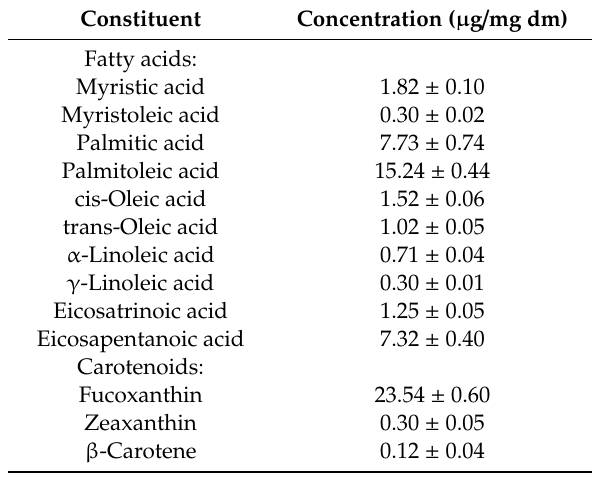
Table 1. Fatty acid and carotenoid spectra of the ethanolic Phaeodactylum tricornutum extract (PTE).